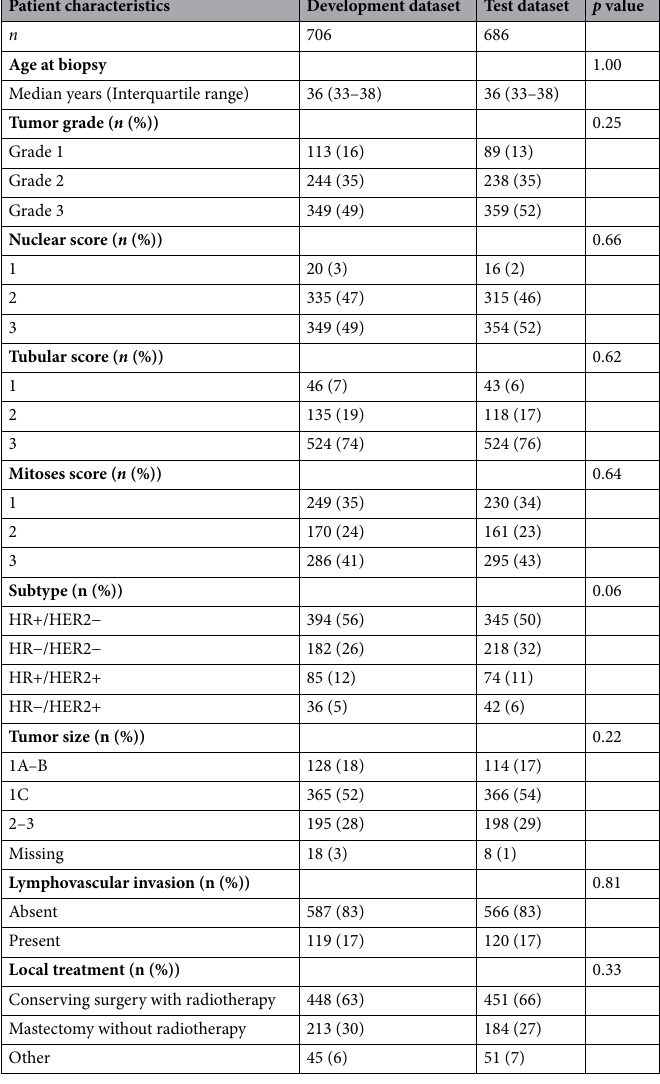
Table 1. Patient characteristics of all 1392 women included in our cohort divided in the development dataset ( n = 706) and test dataset ( n = 686). HR hormone